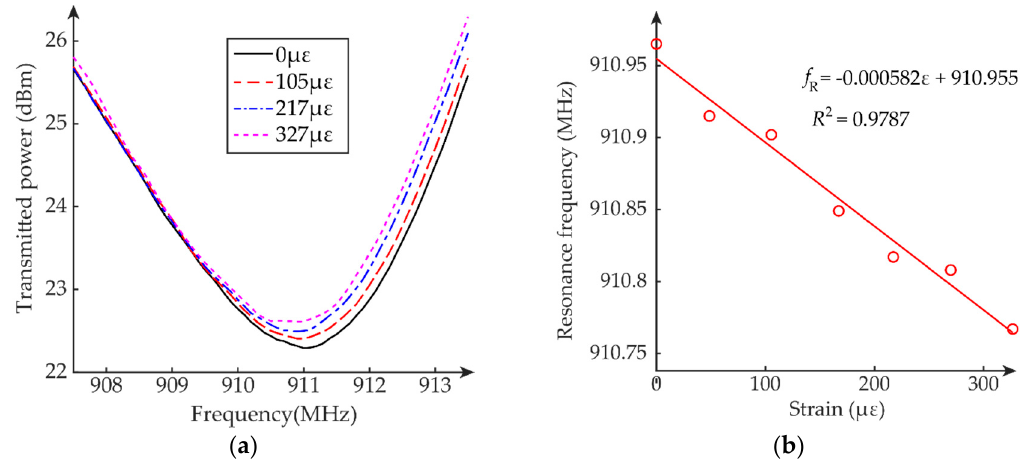
Figure 10. Tensile test results of passive mode test: ( a ) average interrogation power threshold, ( b ) resonance frequency 𝑓 (cid:2902) versus strain 𝜀 .